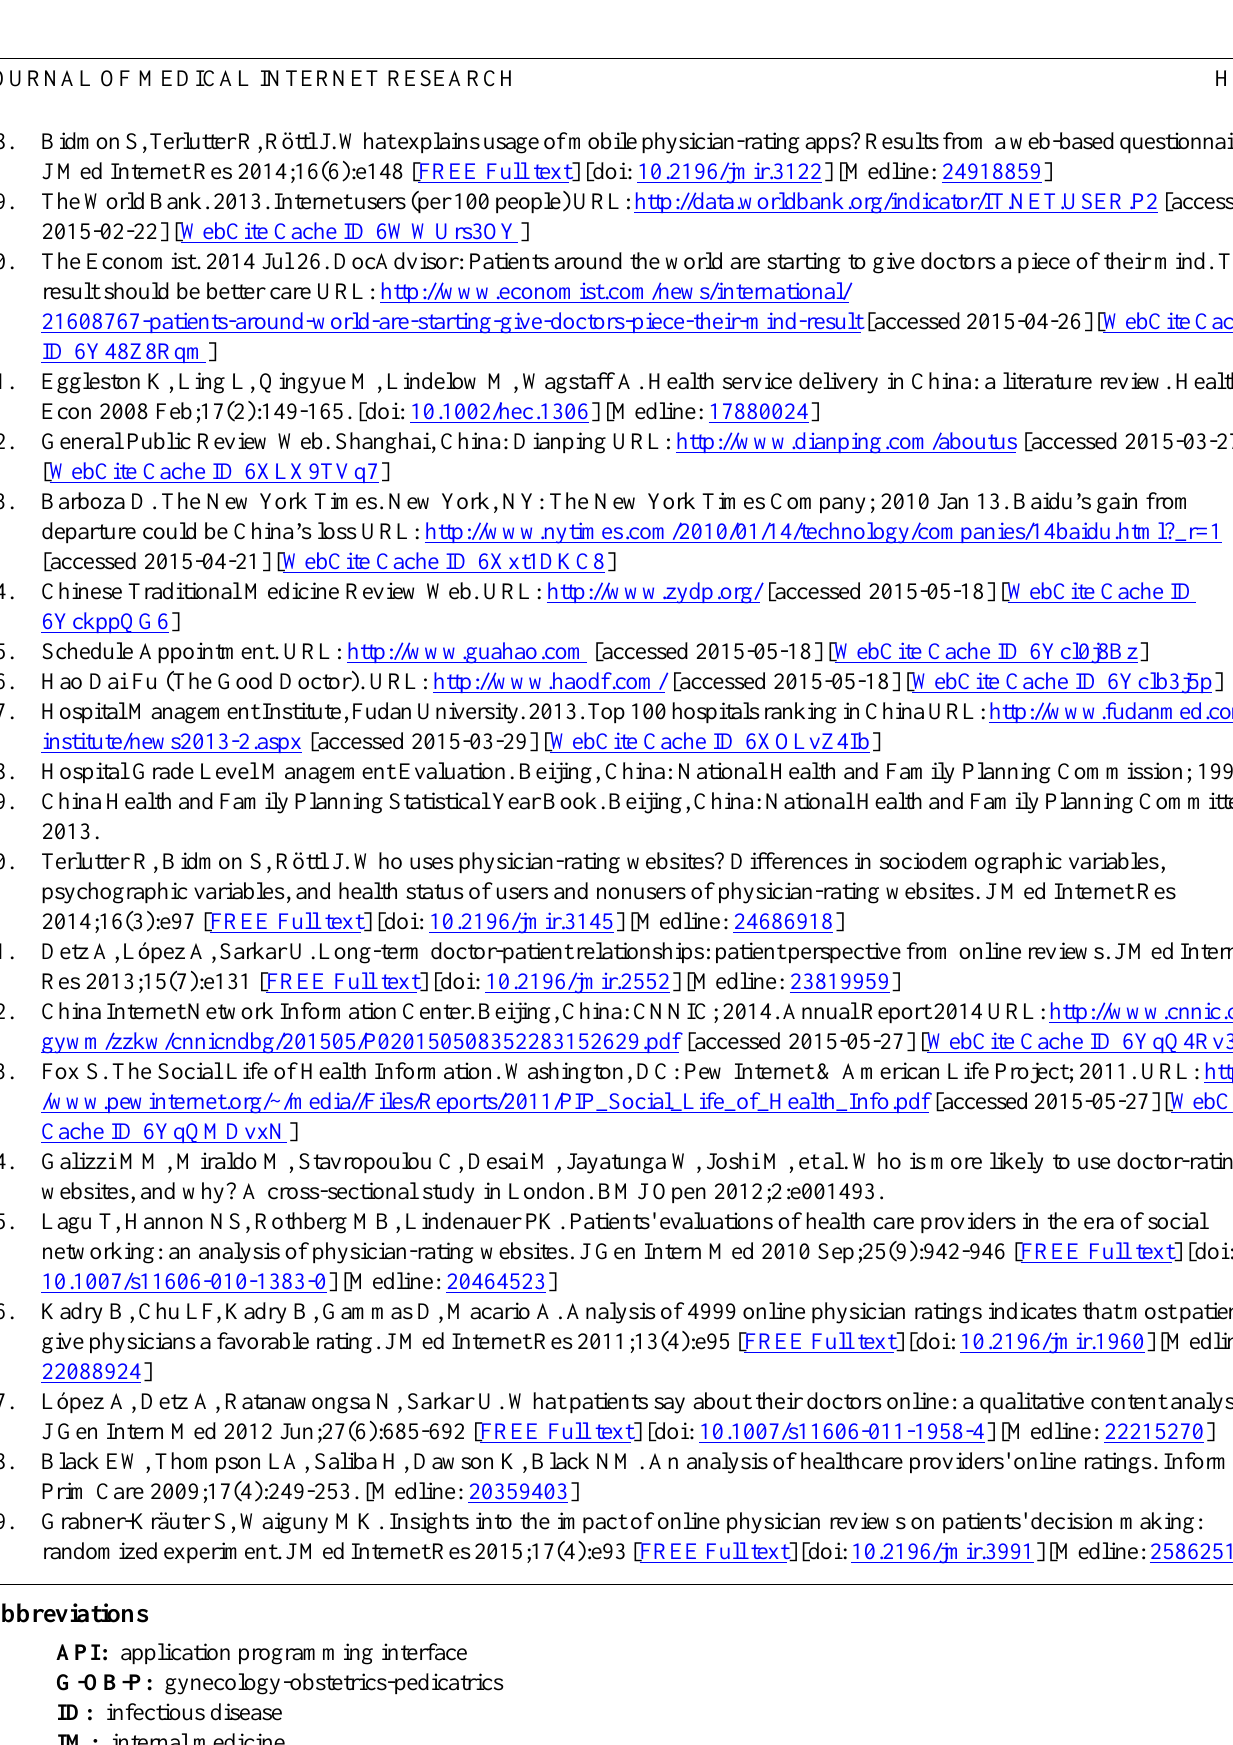
API: application programming